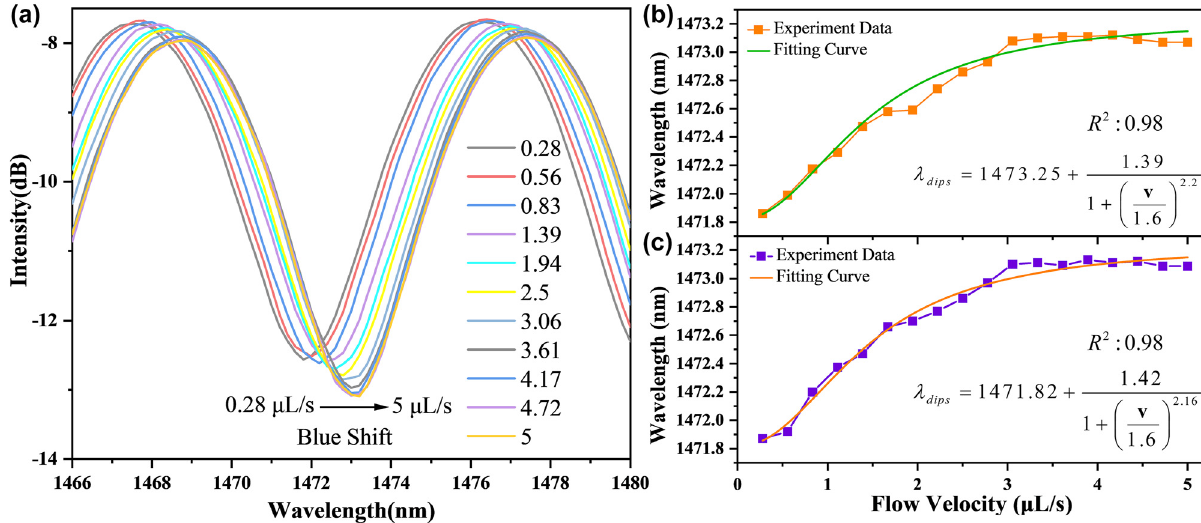
Figure 8: Demodulation of spectra: (a) The transmission spectra of microfluidic flowmeter under different flow velocity in positive direction. (b) Fitting of the dip shifting at 1473.25 nm in positive direction. (c) Fitting of the dip shifting at 1471.82 nm in opposite